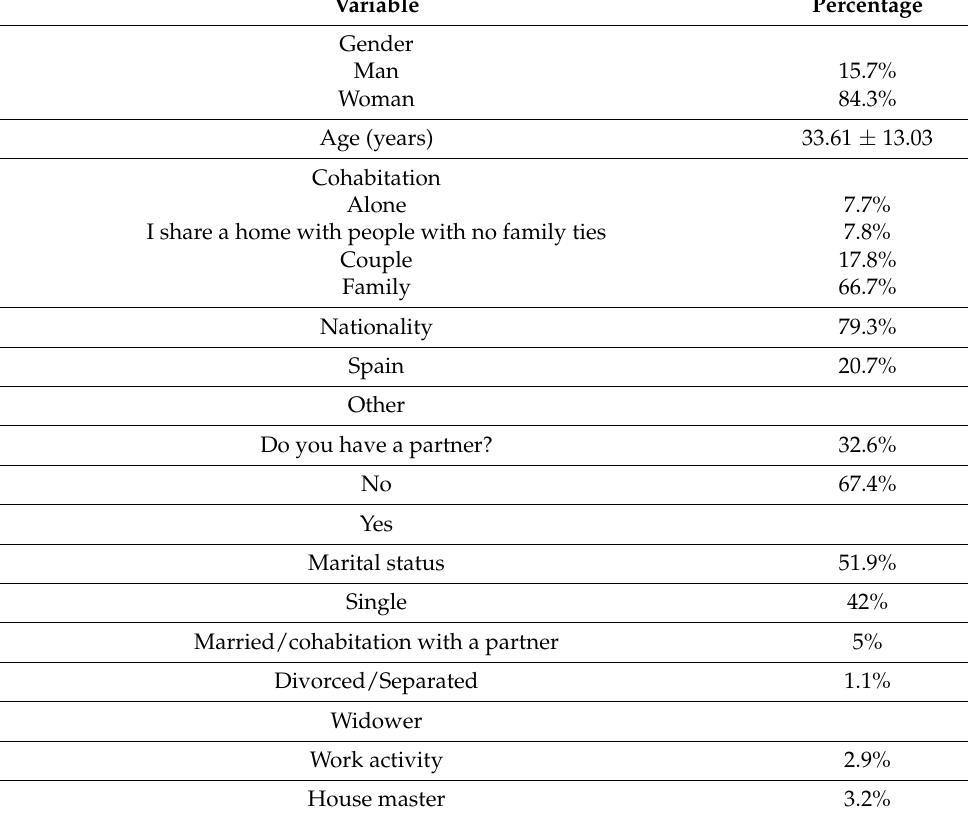
Table 1. Sociodemographic and lifestyle characteristics of the